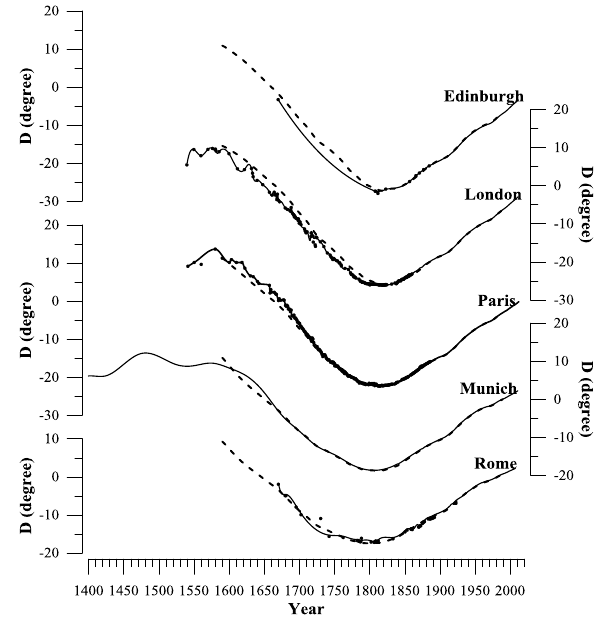
Figure 8. The declination evolution since AD1400 at five locations in Europe. Annual values as obtained by a cubic B-spline interpo- lation on historical observations and observatory data (full black curve) and as obtained from the gufm1 time series (dashed